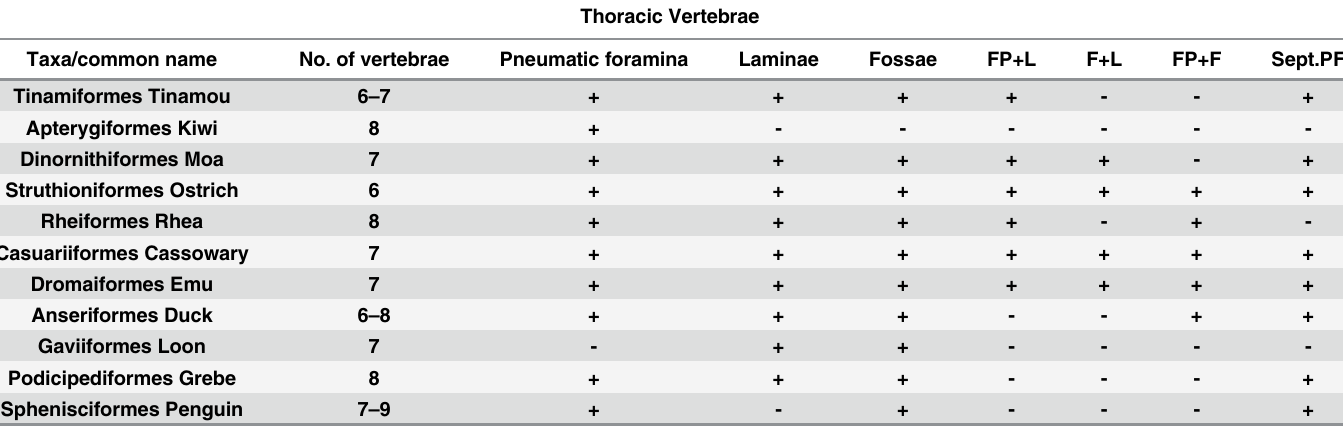
Table 3. Distribution of pneumatic elements of thoracic column per taxon. Presence (+) and absence (-) of pneumatic characters found on the thoracic vertebrae from specimens of the 11 taxa studied. The penguin with the pneumatised vertebrae is Pygoscelis papua (NHMUK unregistered). For more details see S1 Table and S3 – S13 Tables. Abbreviations: PF, pneumatic foramina; F, fossae; L, laminae; Sept., septated.